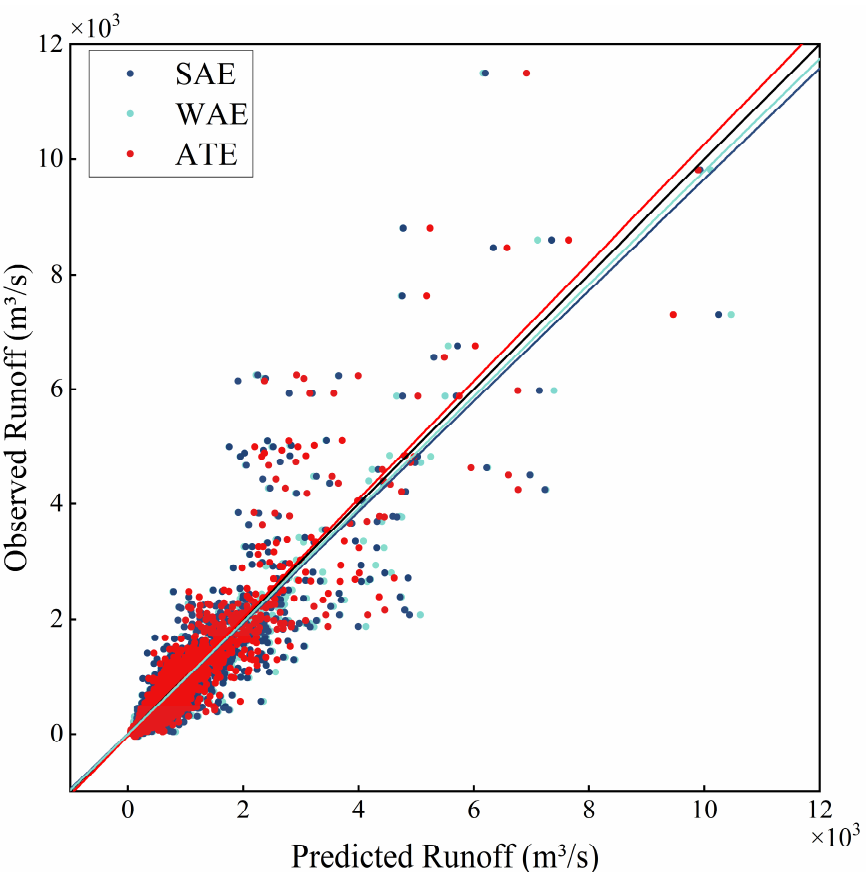
Figure 8. Scatter plot displaying the correlation between the predicted and observed runoff of the stacking models. The differences in predicted runoff amongst the various stacking models are shown in Figure 9. As can be seen in Figure 9, the predicted values of the ATE model approximated the observed values better than the SAE and WAE models, and the scatter points in Figure 8 were more closely distributed around the regression line. Thus, it demonstrates the superiority of the proposed stacking model based on the attention mechanism compared to other models. Moreover, all of the models exhibited a tendency to underestimate runoff during high runoff periods. Nonetheless, the ATE model demonstrated a smaller prediction error compared to the other models. In summary, this finding further confirms the superiority of ATE over the comparative